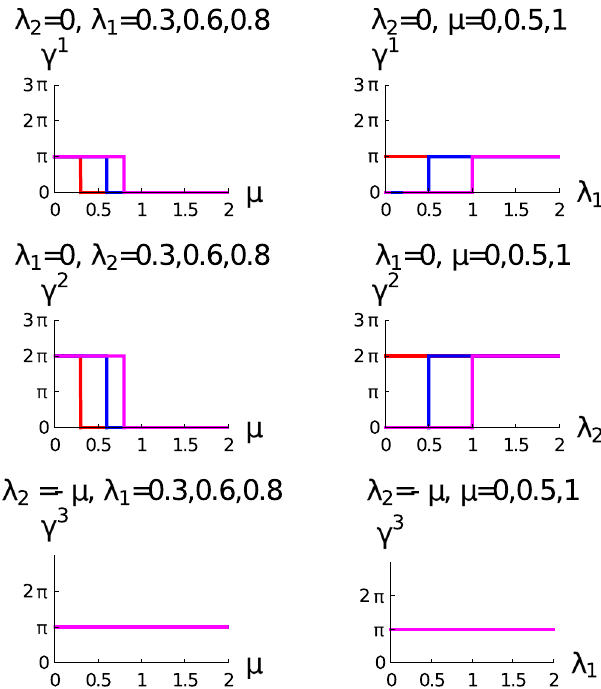
Figure 1. The left and the right columns show respectively the variation of geometric phase ( γ ) with μ and λ 1 . ≠ 0 and λ = 0, λ ≠ 0 and λ = 0 and λ =− μ are for upper, middle and lower row respectively. The curves λ 1 2 2 1 2 in the right column of this figure for μ = 0, 0.5, and 1 are for red, blue and magenta respectively. The curves in the left column for the first and third row of this figure for λ 1 = 0.3,0.6 and 0.8 are for red, blue and magenta respectively. The curves in the left column for the second row of this figure for λ 2 = 0.3,0.6 and 0.8 are red, blue and magenta